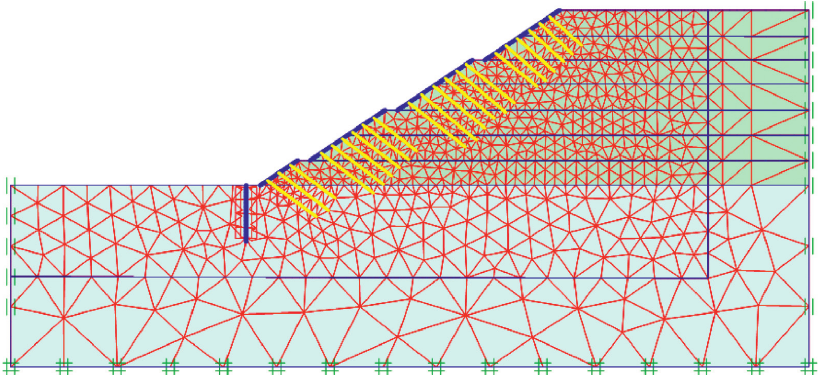
Figure 2: The partition of finite element mesh.